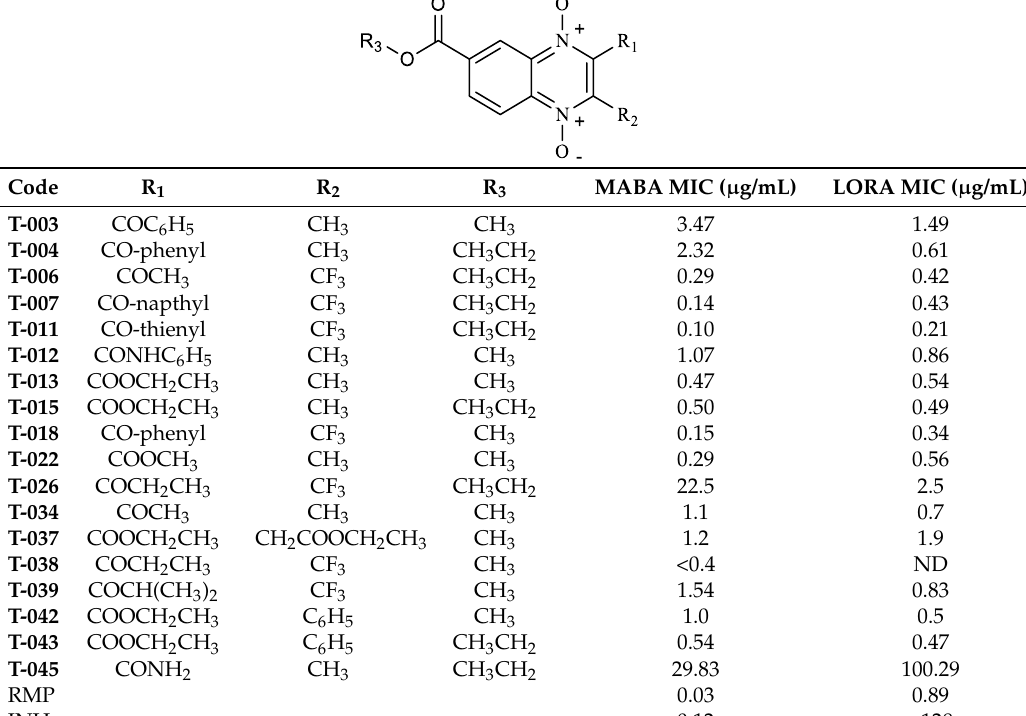
Table 2. Biological activity of methyl and ethyl quinoxaline-7-carboxylate 1,4-di- N -oxide derivatives using the MABA against Mycobacterium tuberculosis strain H37Rv and the LORA against the nonreplicating persistent strain.